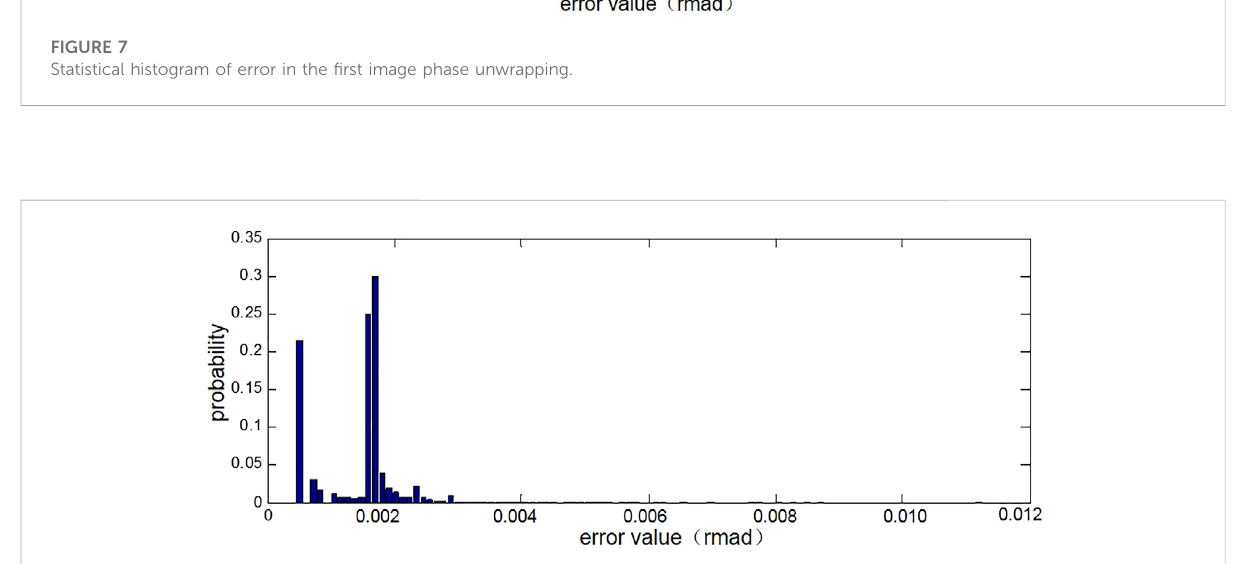
FIGURE 8 Statistical histogram of error in phase unwrapping of the 9th